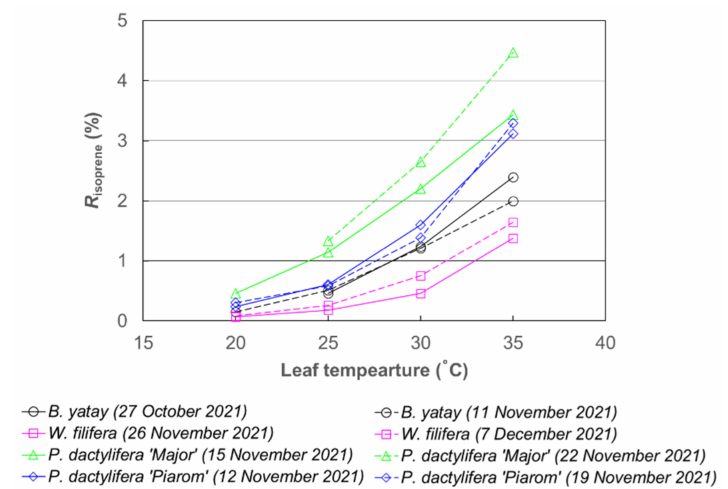
Figure 3. Fraction of carbon emitted as isoprene in carbon assimilated by photosynthesis ( R isoprene ) of B. yatay , P. dactylifera ‘Piarom’, P. dactylifera ‘Major’, and W. filifera ) at leaf temperatures of 20, 25, 30, and 35 ◦ C.